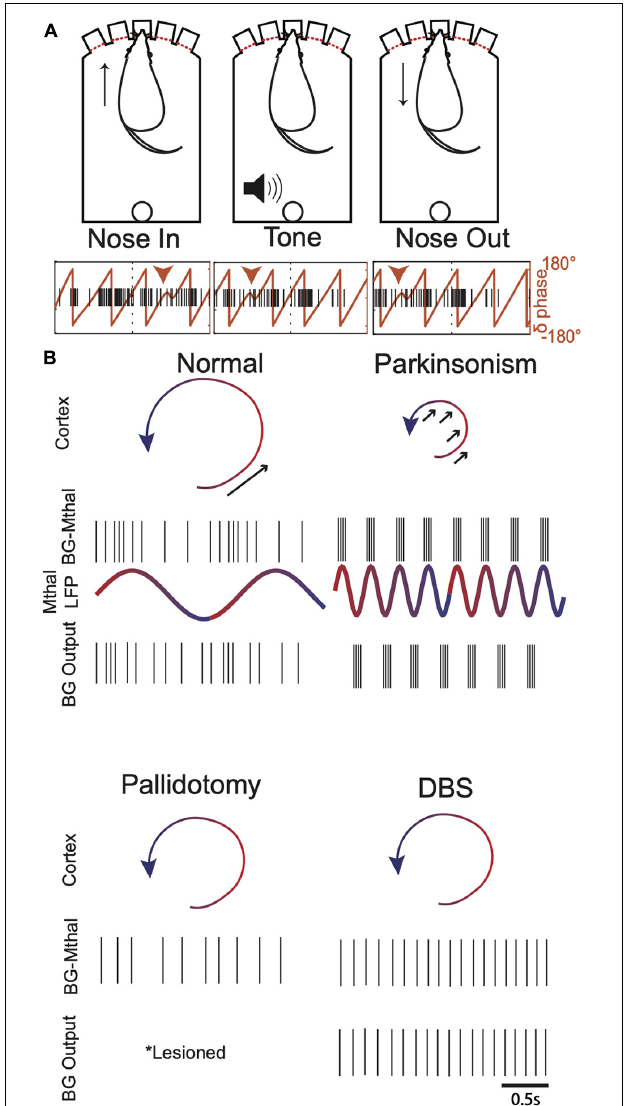
FIGURE 5 | Potential links between Mthal LFP oscillations, cortical dynamics, and single unit BG-Mthal activity. (A) Mthal single units are phase-locked to thalamic delta oscillations. Top—behavioral events during a forced-choice reaction time task, in which a rat pokes its nose in a lit port to initiate a trial. A pure Tone then signals the rat to withdraw its nose and poke an adjacent port. Bottom—single trial delta LFP phase and single unit firing during task performance. Note that this unit has a preferred delta phase during which its activity increases. This phase-locking was characteristic of units whose activity predicted the speed of the subsequent nose withdrawal and poke into an adjacent port. Adapted with permission from Gaidica et al. (2020). (B) Illustrations of potential pallidal-thalamocortical interactions in healthy subjects, parkinsonism, post-pallidotomy, and during DBS. In healthy subjects, Mthal activity phase-locked to LFP delta oscillations provide well-timed input to enhance cortical state space rotations (arrow). In parkinsonism, thalamocortical neurons synchronized to beta rhythms deliver ill-timed perturbations to cortical dynamics, sometimes enhancing but more often opposing state space rotations (arrows). After pallidotomy, BG-Mthal activity is regulated entirely by cortical input (either directly or via the thalamic reticular nucleus). The BG-Mthal firing pattern is speculative since BG-Mthal